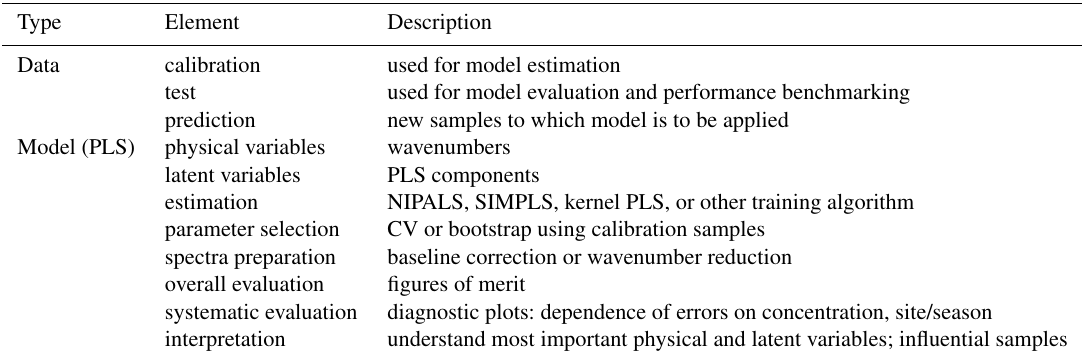
Table B1. Model elements and their